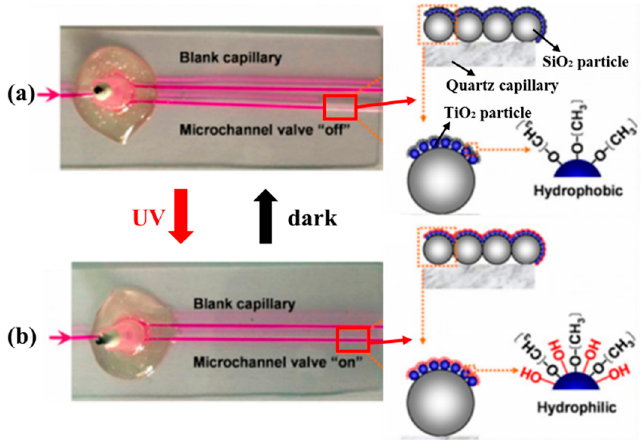
Figure 14. Schematic of UV/dark actuated wettability conversion in the surface of the microvalve [119]: ( a ) Off status and hydrophobic composite structure before UV irradiation; ( b ) On status and hydrophilic composite structure after UV irradiation.